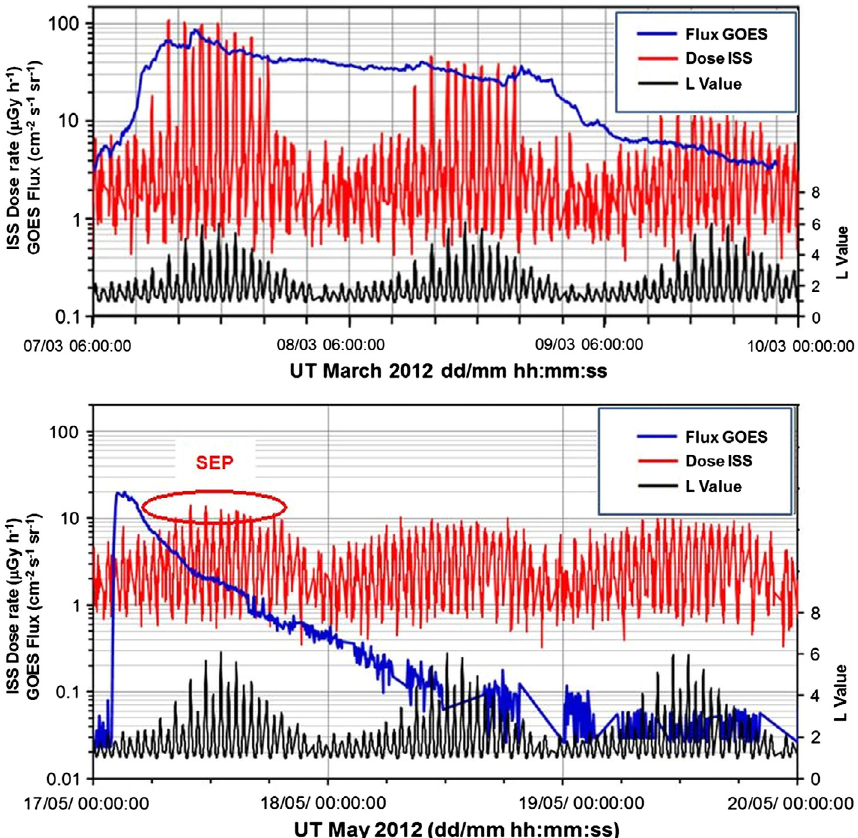
Fig. 7. Proton flux F with energies (cid:3) 100 MeV measured by GOES-13 (blue curve), the dose rate in D1 detector of Liulin-5 measured outside the SAA (red curve), and the corresponding L -values (black curve) versus time. Upper plot (taken from Semkova et al. 2013c) displays data from March 07, 07:00 UT to March 09, 22:00 UT, 2012. Bottom plot – data from May 17, 00:00 UT to May 20, 00:00 UT,